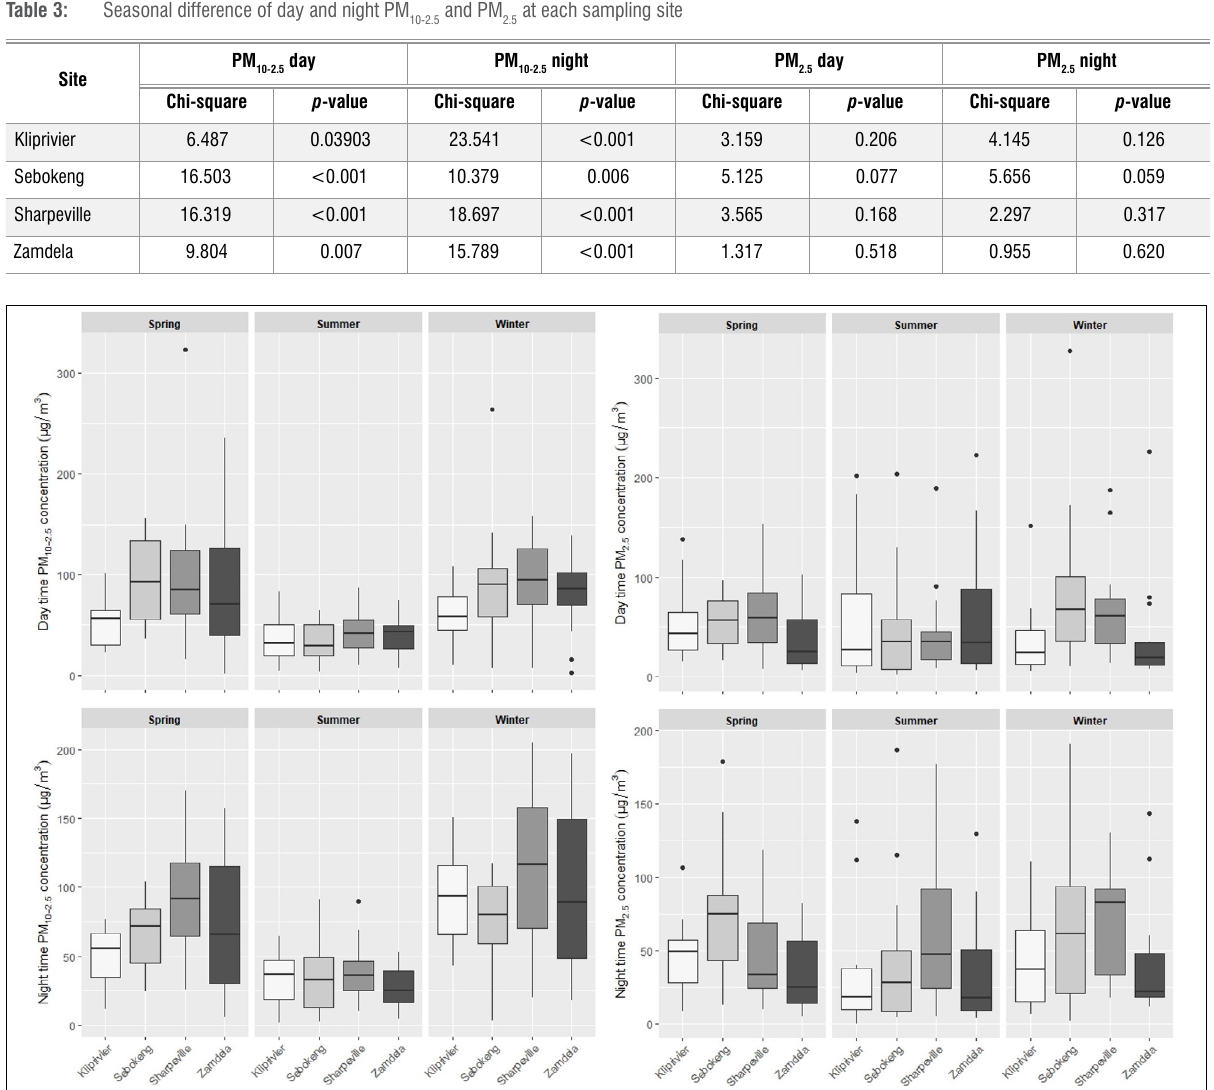
Seasonal difference of day and night PM